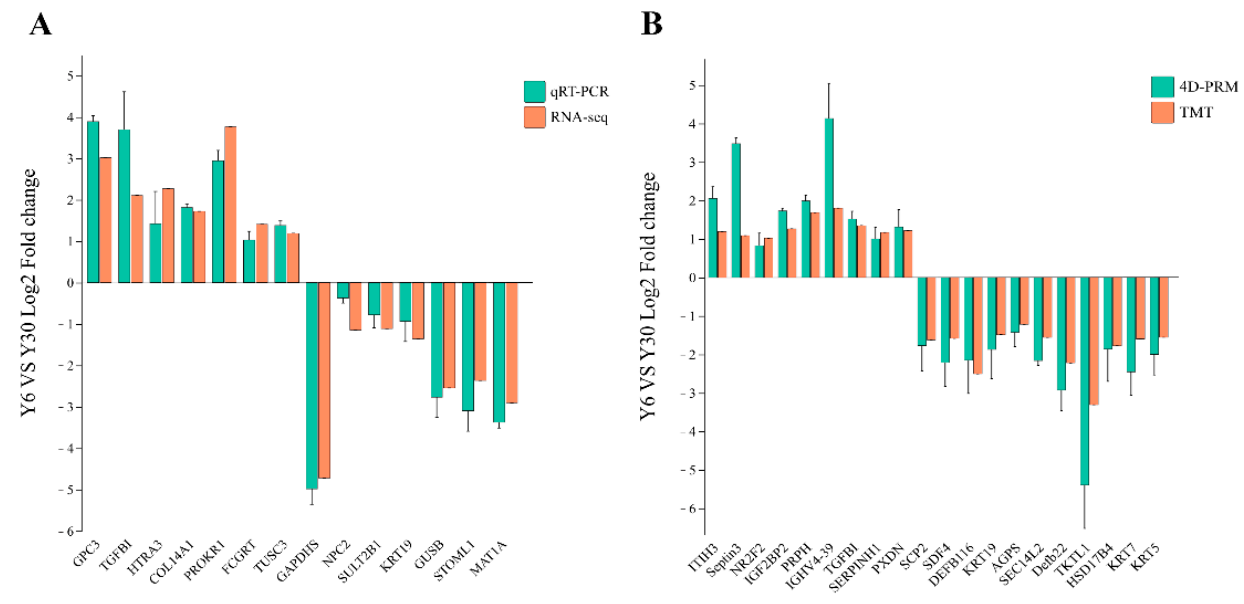
Figure 9. Differential genes and differential proteins were verified through qRT-PCR and 4D-PRM. Figure 9. Di ff erential genes and di ff erential proteins were veri fi ed through qRT-PCR and 4D-PRM. ( A ) Differential genes were verified through qRT-PCR, and the results were presented as Log 2 FC. ( A ) Di ff erential genes were veri fi ed through qRT-PCR, and the results were presented as Log 2 FC. ( B ) The selected differential proteins were validated through ( B ) The selected di ff erential proteins were validated through 4D-PRM.